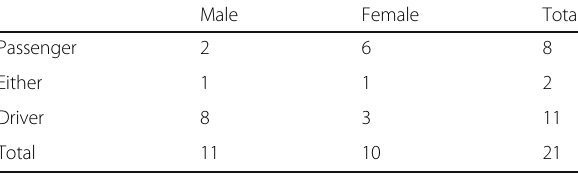
Table 3 Characteristics of the sample interviewed ( n = 21)